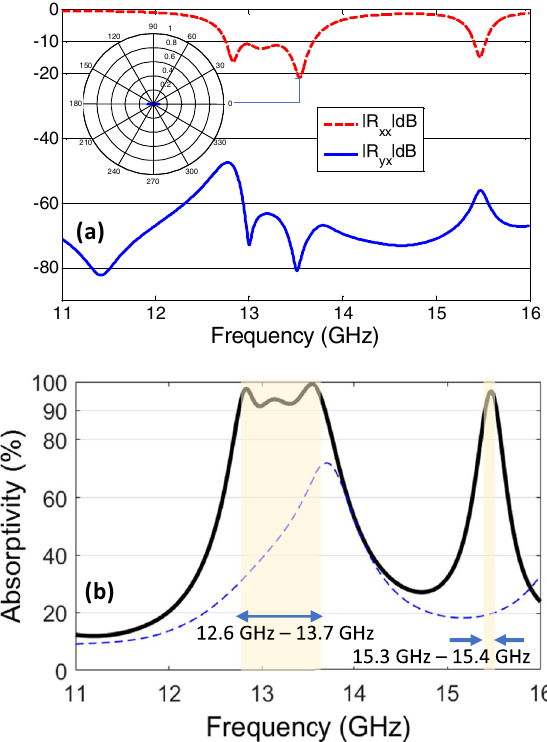
Figure 4. ( a ) Magnitude of reflection coefficients of co- and cross- polarized reflection for antireflecting metasurface. Inset shows the contour of time varying orientation of reflected electric field vector at resonance frequency. ( b ) Absorptivity spectrum of antireflecting metasurface absorber at normal incidence shown as solid black line. The near perfect absorption bandwidth region is highlighted. The absorptivity of co-directional split ring metasurface shown as dashed blue line is provided as reference.